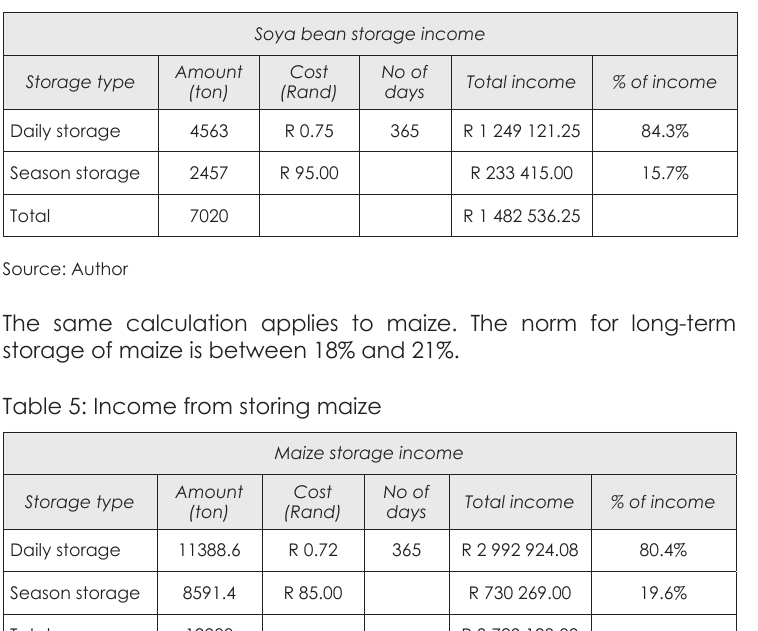
Table 4: Income from storing soya beans